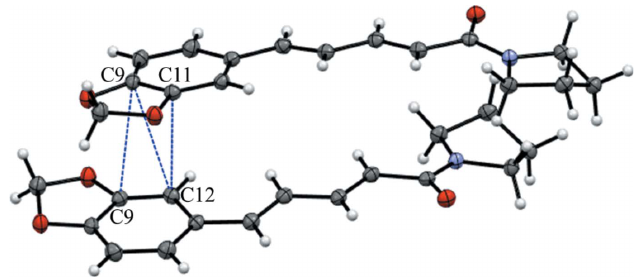
Figure 6 Fragment of the crystal of (II) showing close C (cid:2)(cid:2)(cid:2) C contacts due to (cid:2) – (cid:2)